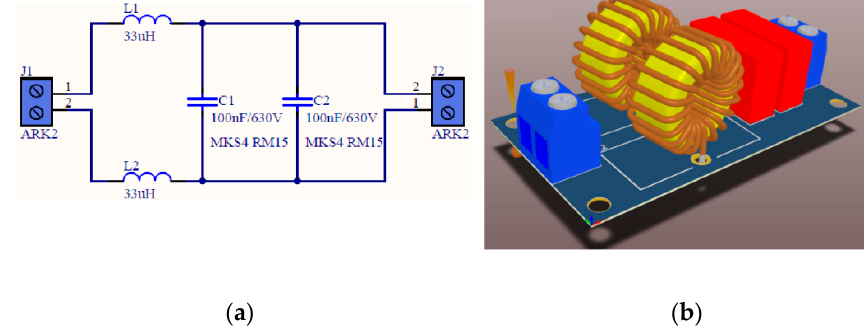
Figure 3. LC filter with two THT 33 μ H chokes: ( a ) filter scheme, ( b ) 3D view of the board (57.5 mm width and 31.0 mm height, nominal current 5 A).